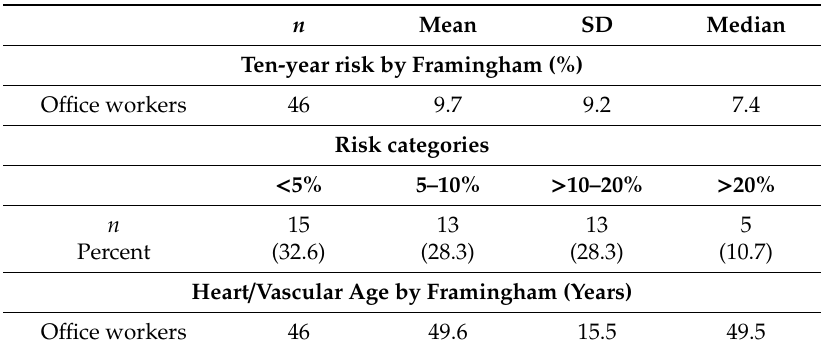
Table 4. Representation of the 10-year risk of cardiovascular events and heart / vascular age of the study population.